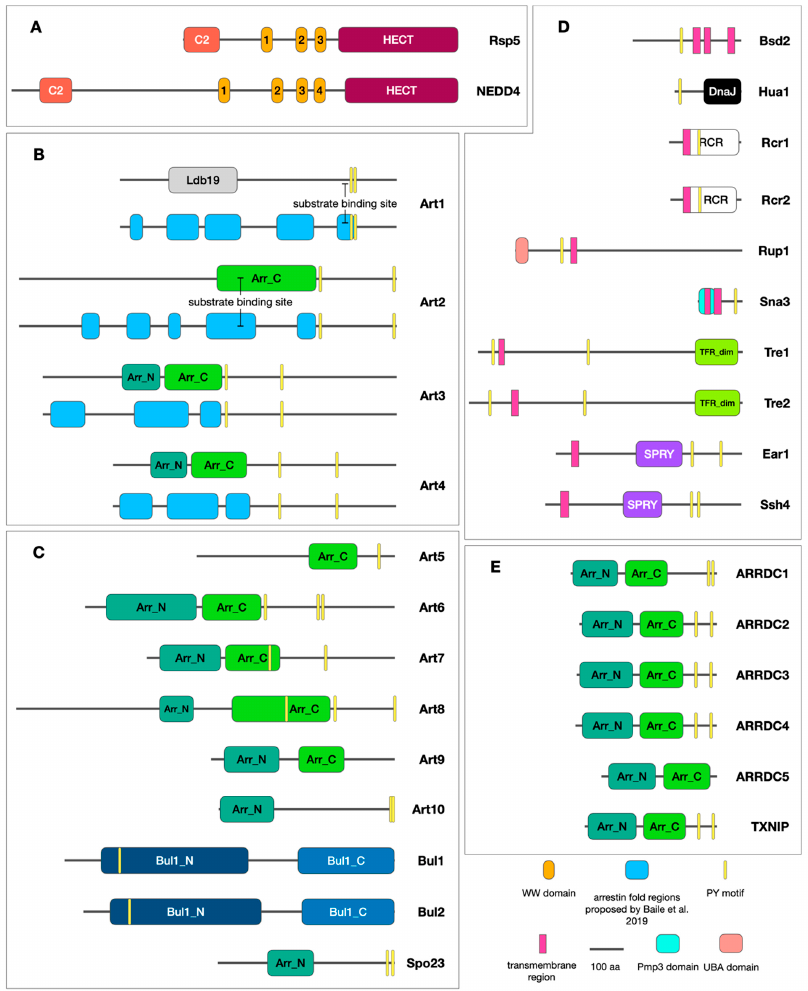
Figure 1. Schematic representation of the domain structure for the proteins of the Rsp5/NEDD4–adaptor complexes. ( A ) Schematic representation of the domain structure for the yeast Rsp5 and human NEDD4 ubiquitin ligases. ( B ) Schematic representation and comparison of predicted arres- tin-N (Arr_N), arrestin-N-like (Ldb19), and arrestin-C (Arr_C) domains as defined in the Pfam da- tabase [25] and arrestin fold regions as proposed by Baile et al. 2019 (arrestin domain disrupted by multiple insertions) [26]; for yeast α -arrestins Art1-4; known substrate binding sites were indicated. ( C ) Schematic representation of domain structure for yeast α -arrestins Art5-10, Bul1-2, and Spo23. ( D ) Schematic representation of domain structure for yeast non-arrestin adaptors of the Rsp5 ligase. ( E ) Schematic representation of domain structure for human α -arrestins. Accession numbers for predicted domains as defined in Pfam database: Ldb19 (PF13002), Arr_N (PF00339), Arr_C